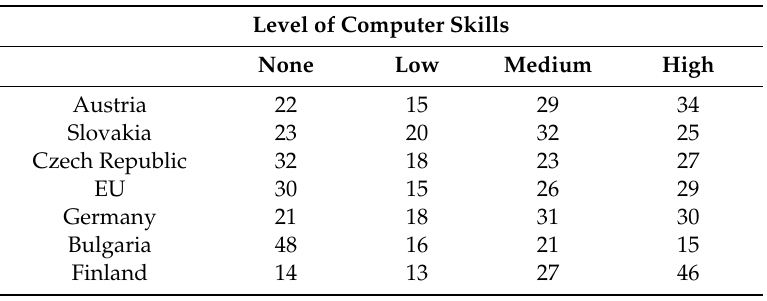
Table 2. Share of computer skills in 2015 in population in selected